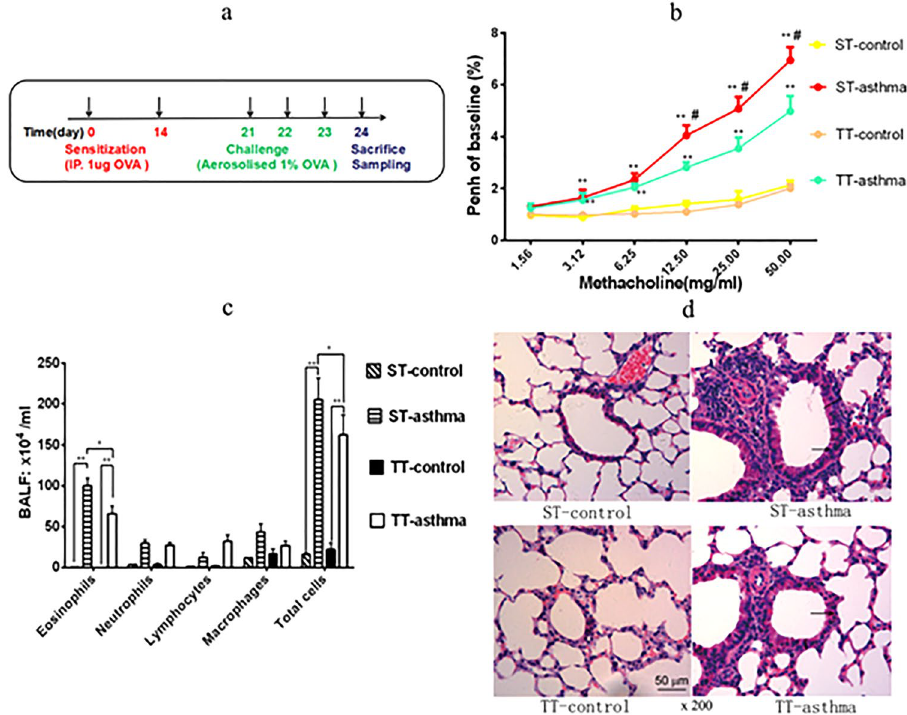
Figure 1. Effects of the changing ambient temperature on asthma mice. ( a ) The experimental procedures using to develop an asthma mouse model was generated by using OVA sensitization and challenge. ( b ) The AHR in mice after being inhaled Mch was measured recorded using flow plethysmography. ( c ) Total and differential cells numbers in BALF that were determined by microscopyicobservation. The data were averaged from for five randomly selected fields of each mouse. ( d ) The representative photomicrographs (200 × )of lung sections are shown. Black arrows indicate areas of peribronchiolar inflammatory cell influx and edema. Black bars indicate the amount of bronchiolar remodeling. ST: standard temperature (20 °C); TT: thermoneutral temperature (30 °C). The data presented are mean ± SEM. ** denotes P < 0.01 (ST-control vs. ST-asthma or TT-control vs.TT-asthma); # denotes P < 0.05 (TT-asthma vs. ST-asthma) in Fig. 1b. * or ** denotes P < 0.05, P < 0.01 respectively between two groups in Fig. 1c,d (n = 6 mice per group).